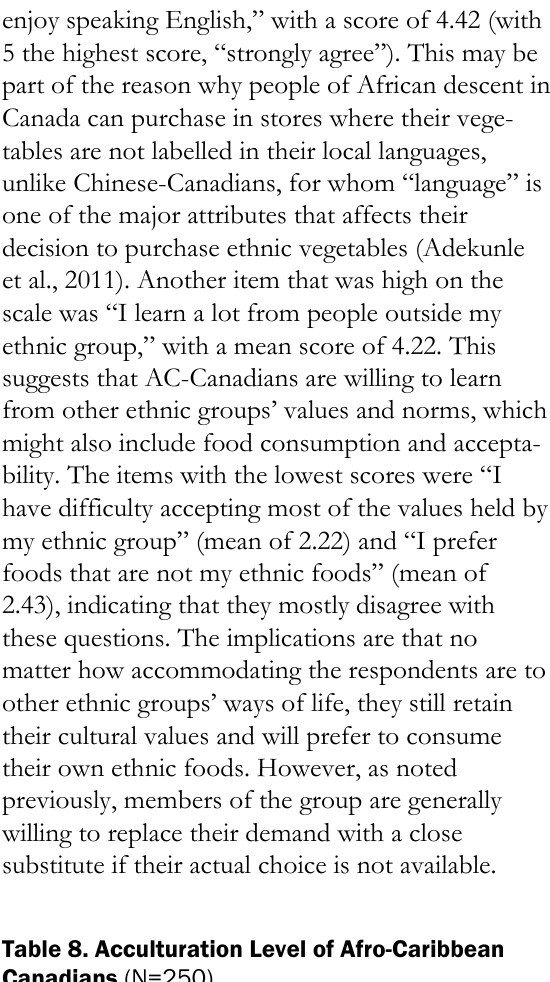
Table 8. Acculturation Level of